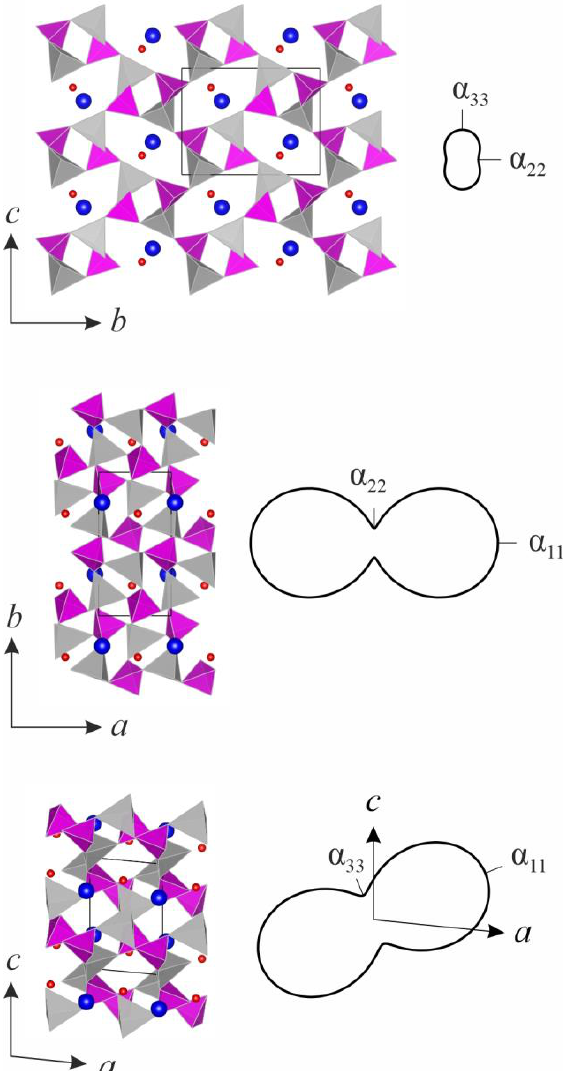
Figure 6. Crystal structure of BaAs 2 Zn 2 O 8 · H 2 O with the section of thermal deformations. AsO 4 and ZnO 4 tetrahedra are given in purple and grey, respectively. Ca and O atoms are presented as blue and red spheres, respectively. a , b and c denote the crystallographic axes, α 11 , α 22 and α 33 show the thermal expansion coefficients along crystal-physical